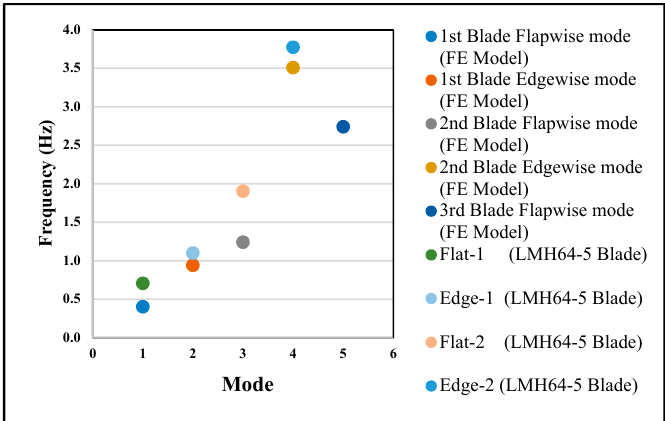
Figure 8. The 1st five modal frequency of the blade (FE mode) and the 1st four “reactionless” modal frequency of LMH64-5 blade [29] at 12.1 rpm.